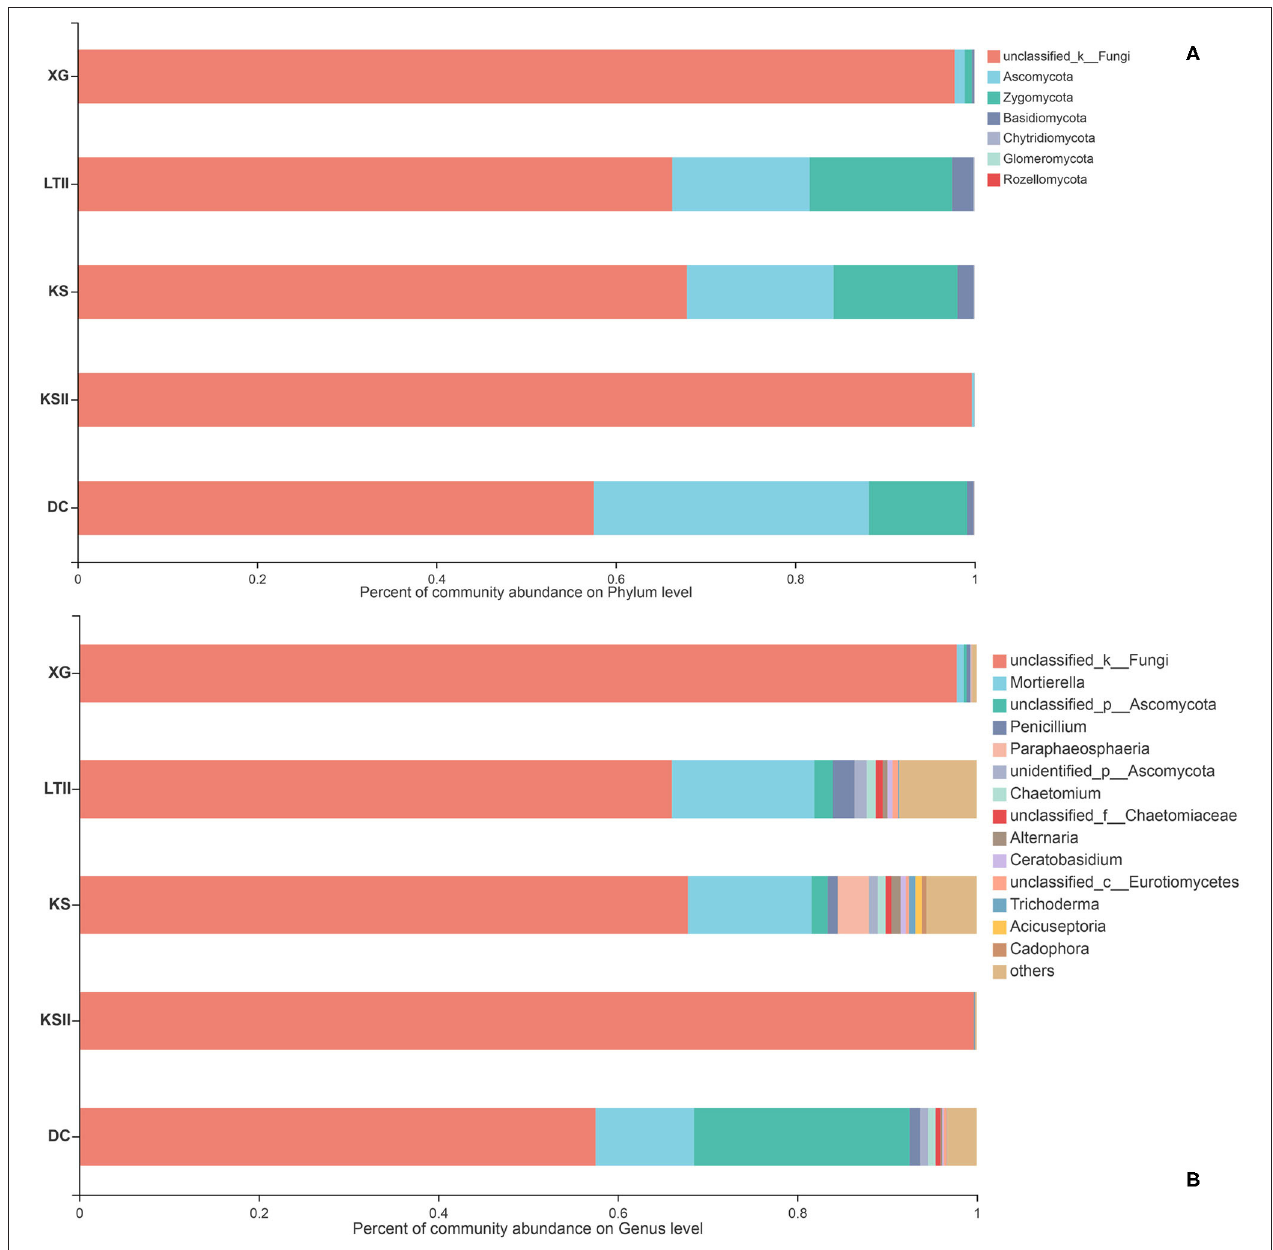
FIGURE 4 | Relative abundance of endophytic fungi of Batrachium bungei collected from five sampling sites at the phylum level (A) and genus level (B) . When the relative abundance was < 0.005%, they were merged together into the “others” group.